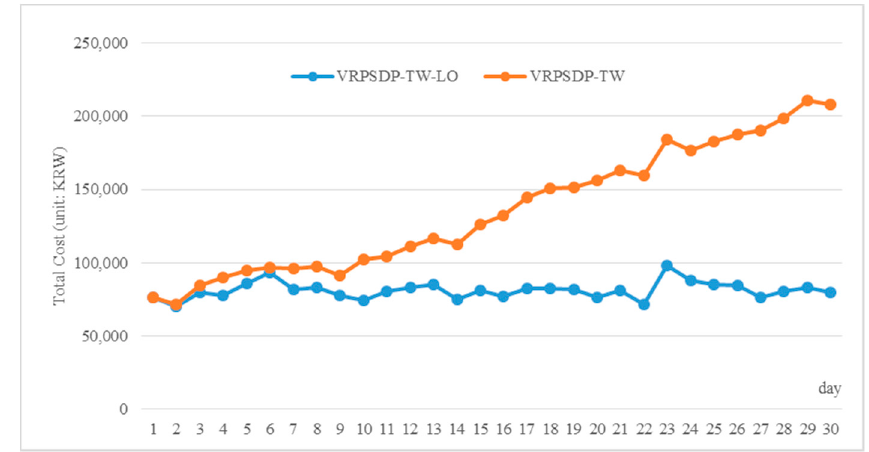
Figure 4. Daily total cost of VRPSDP-TW-LO and VRPSDP-TW.